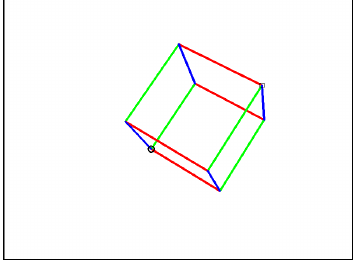
Figure 4. Baseline image of a 1m cube. Edges are color-coded by their axis direction, XYZ ∼ RGB. The origin is circled, and the square around the opposite corner (1,1,1) illustrates the extent of Figure